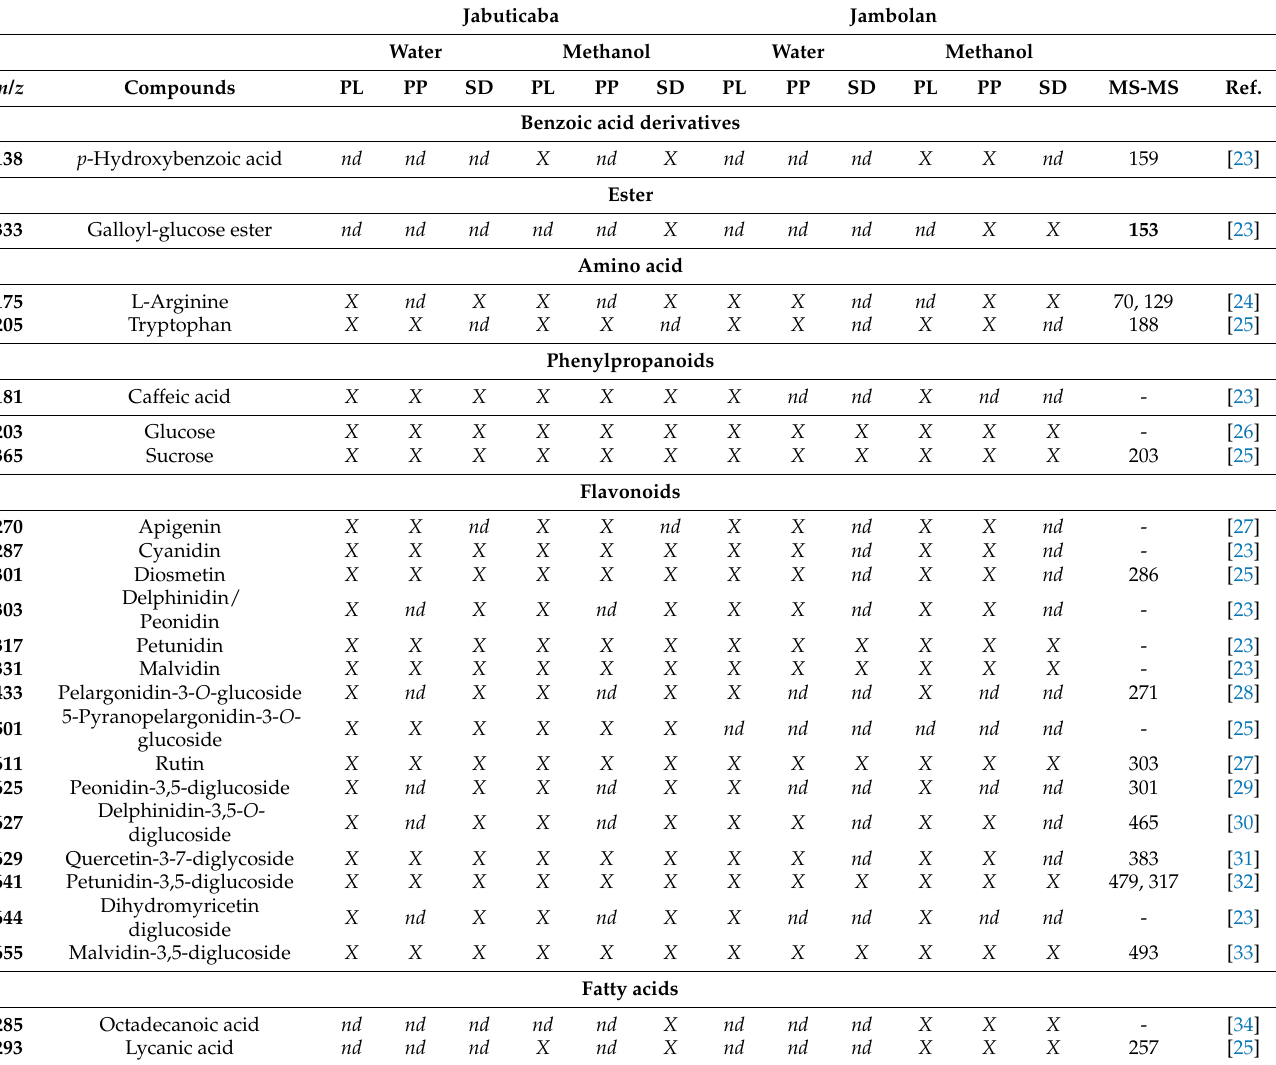
Table 2. Compounds provisionally identified in the peel (PL), pulp (PP) and seeds (SD) of jabuticaba and jambolan fruits by (+)